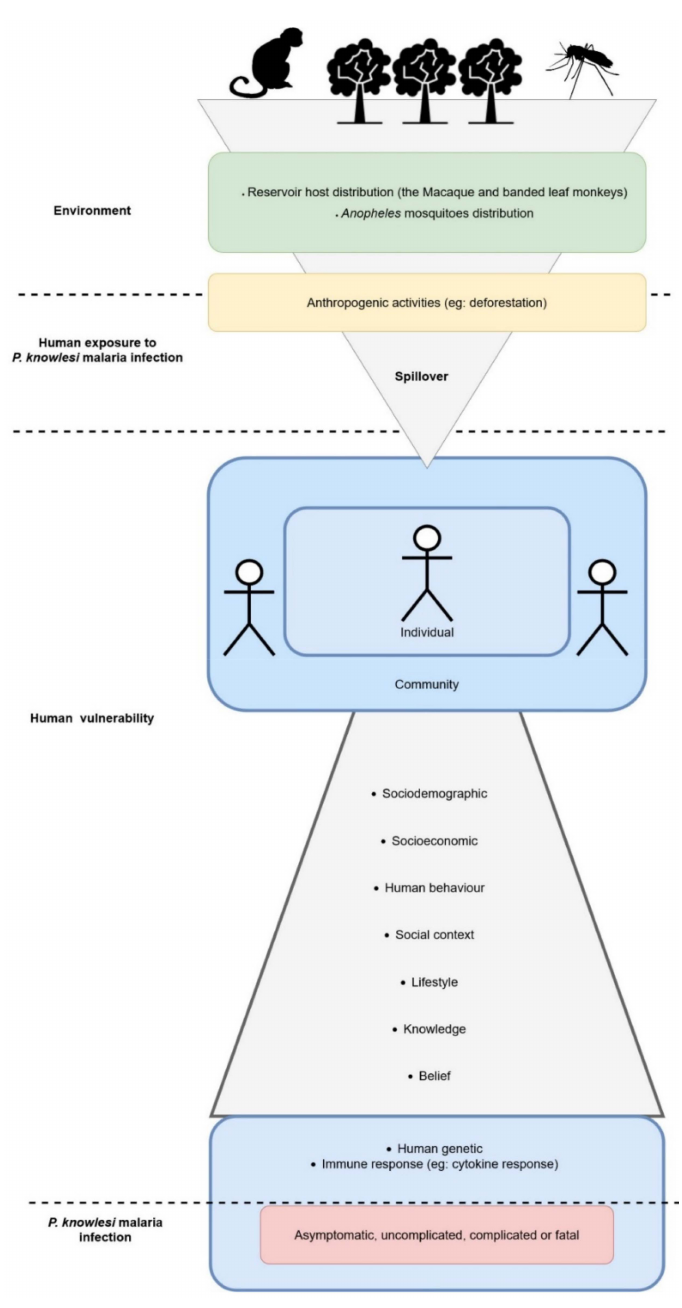
Figure 3. The vulnerable factors of P. knowlesi malaria infection in the human